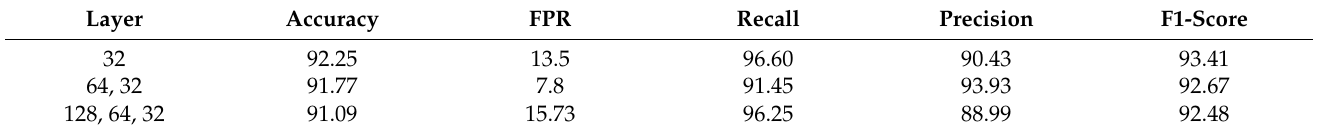
Table 5. Performance analysis on NSL-KDD for different numbers of fully connected layers.